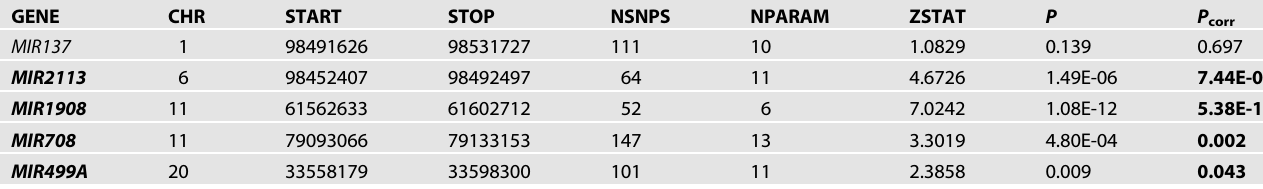
Overview of the results of the gene-based tests for the fi ve microRNA (miRNA) coding genes, as performed using MAGMA [38] and the summary statistics of a large bipolar disorder (BD) genome-wide association study [16]. Chromosomal positions are given according to hg19. The miRNA coding genes indicated in bold font showed a signi fi cant association with BD after Bonferroni correction for multiple testing. CHR chromosome, NSNPS number of single-nucleotide polymorphisms, NPARAM number of parameters used in the model, ZSTAT z-value of the miRNA coding gene, P P -value of the miRNA coding gene, P corr P -value after Bonferroni correction for multiple